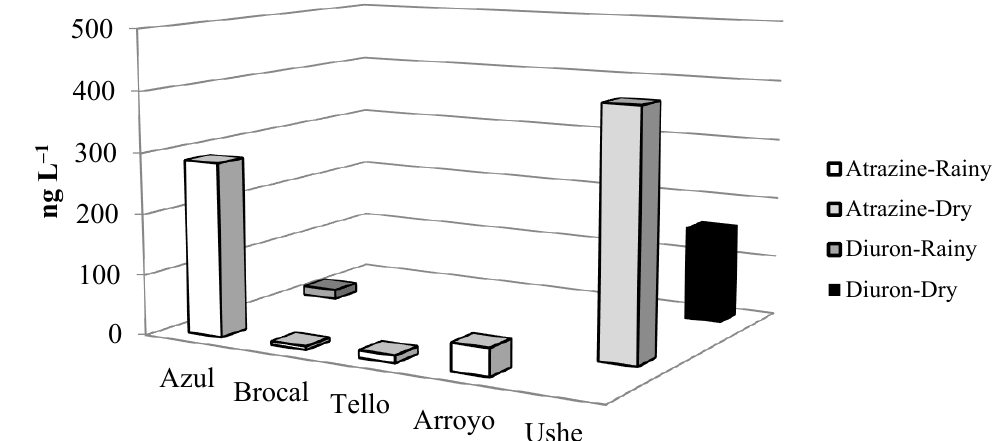
Figure 4. Seasonal distribution of herbicides atrazine and diuron.